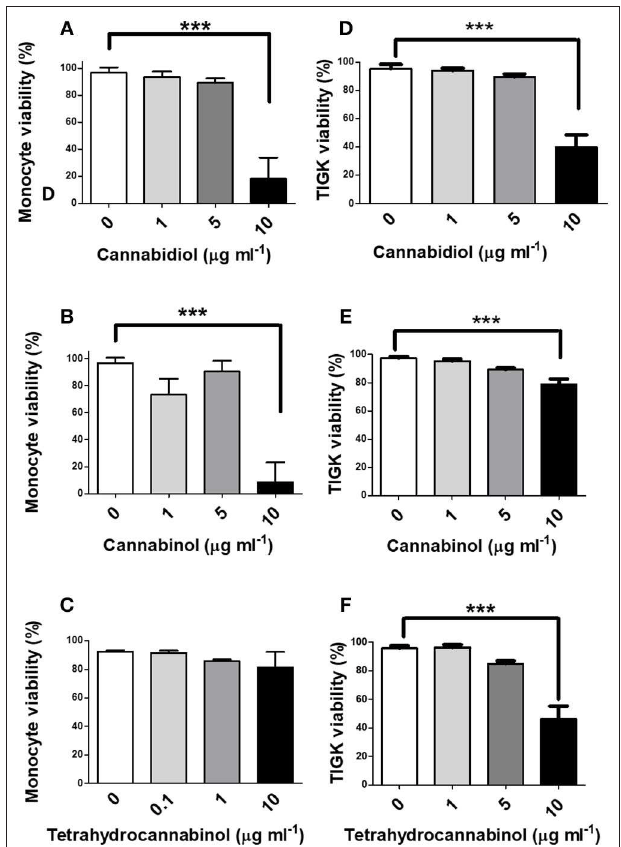
FIGURE 2 | High doses of phytocannabinoids reduce innate cell viability. Primary human monocytes were cultured in the absence or presence of varying concentrations (0–10 µ g/ml) of (A) CBD, (B) CBN, or (C) THC and viability established by MTT assay. TIGK cells were also cultured in the absence or presence of varying concentrations (0–10 µ g/ml) of (D) CBD, (E) CBN, or (F) THC and viability established by trypan blue exclusion. Data represent the mean ± SD of three biological replicates. *** p ≤ 0.001, as determined by